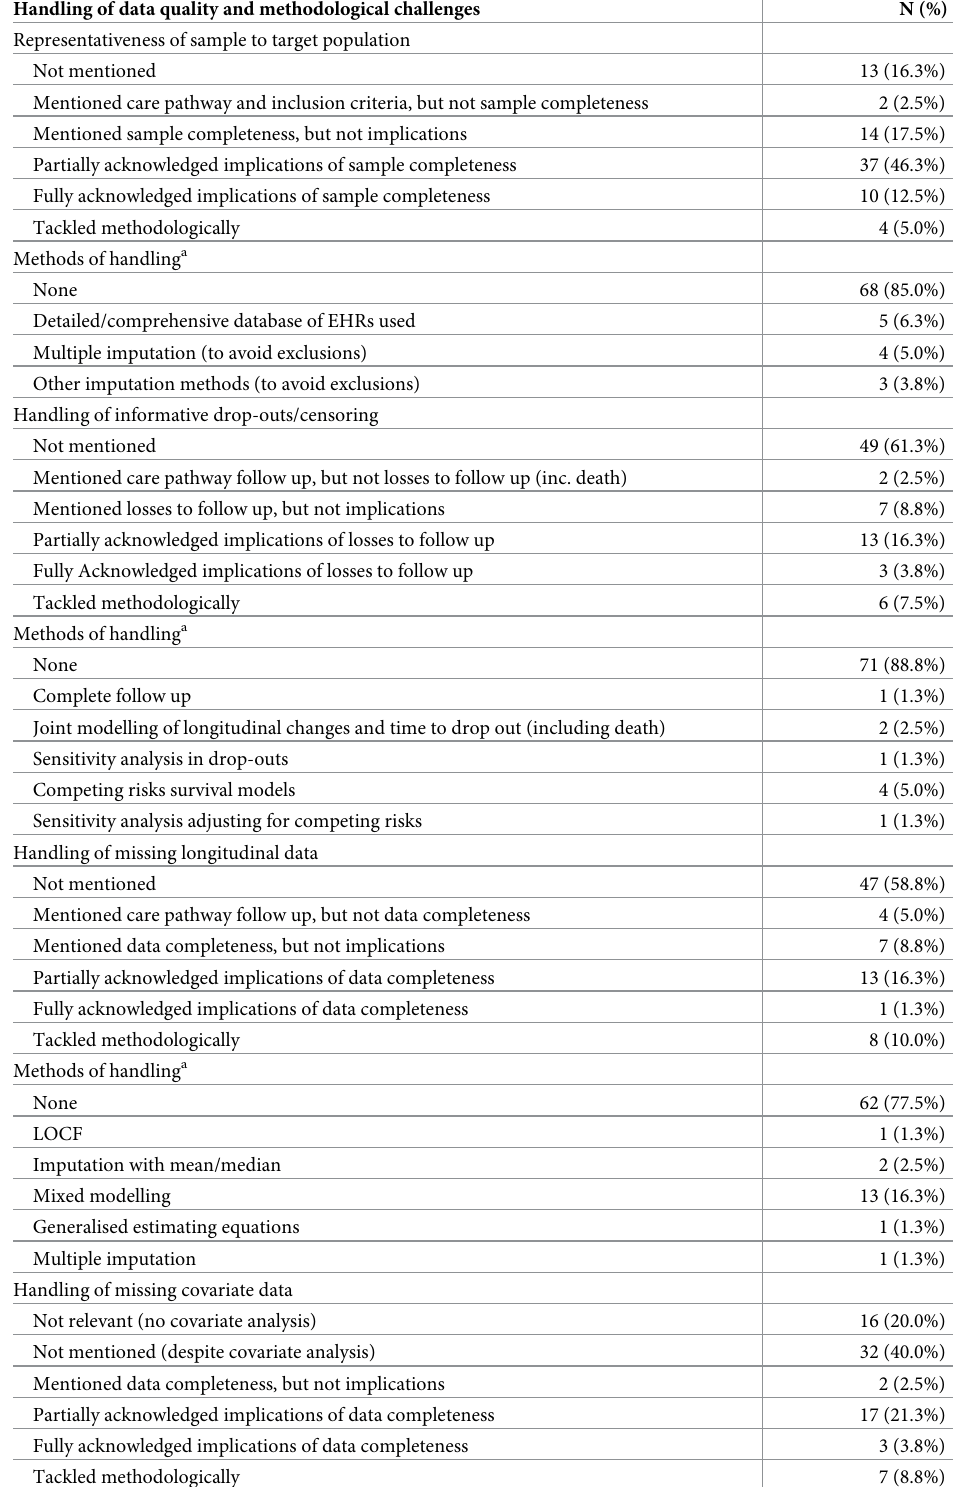
Table 3. Critique of handling of data quality and methodological challenges (N =